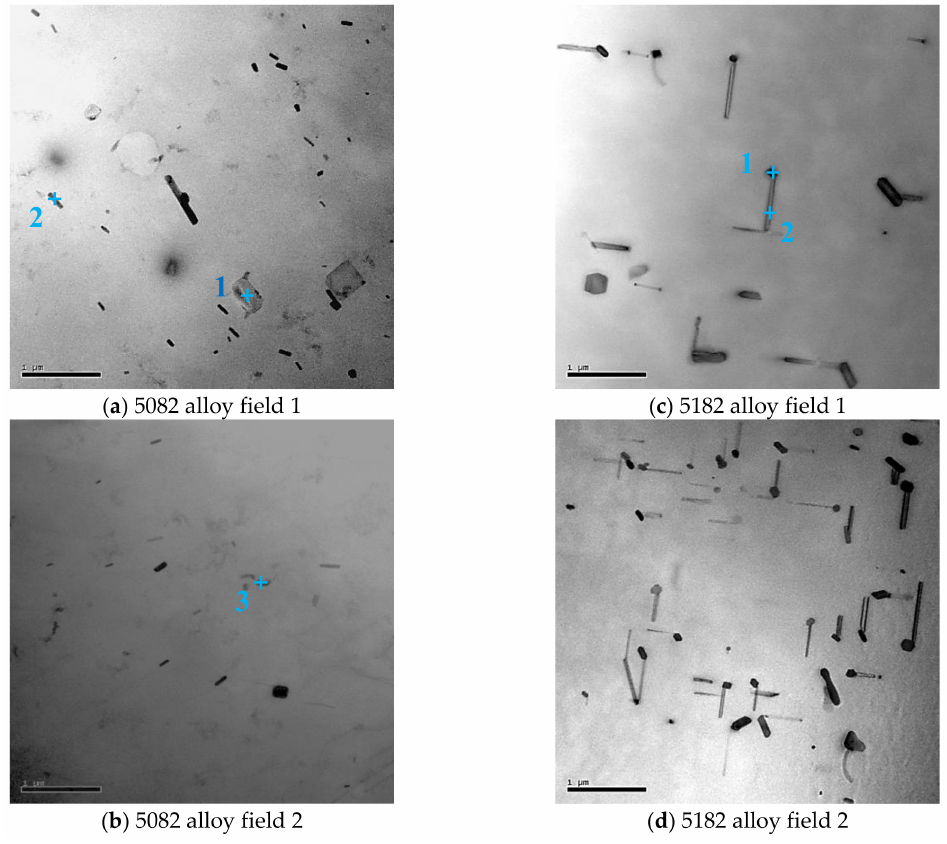
Figure 9. TEM images of 5082 and 5182 alloys. ( a ) 5082 alloy field 1, ( b ) 5082 alloy field, ( c ) 5182 alloy field 1, ( d ) 5182 alloy field